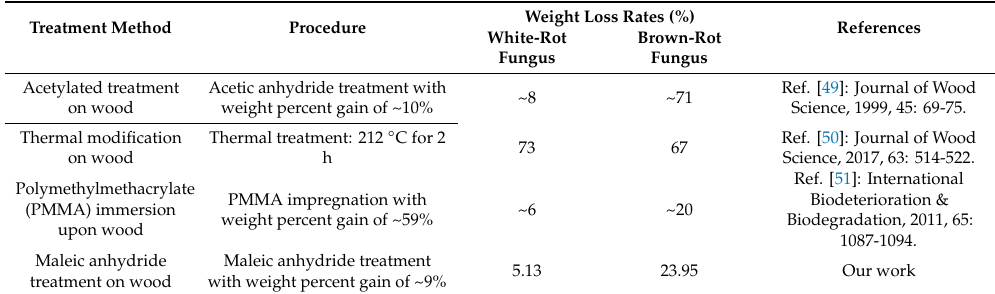
Figure 4. Durability comparison of MAn-bulked wood and the control wood. ( a ) Variations of reduction in water absorptivity (RWA) and ASE of the MAn-bulked wood after immersed in water for different times. ( b ) Variations of water contact angles of the MAn-bulked wood and the control wood after water droplet dropped on wood surface for 120 s. ( c ) Comparison of weight loss rates (WLR) of the control wood and the MAn-bulked wood against white-rot and brown-rot fungi. ( d ) SEM morphology of the control wood. ( e ) SEM morphology of the control wood on decay by white-rot fungus. ( f ) SEM morphology of the control wood on decay by brown-rot fungus. ( g ) SEM morphology of the MAn-bulked wood. ( h ) SEM morphology of the MAn-bulked wood on decay by white-rot fungus. ( i ) SEM morphology of the MAn-bulked wood on decay by brown-rot fungus. Table 1. Comparison of decay resistance of our work with other reported